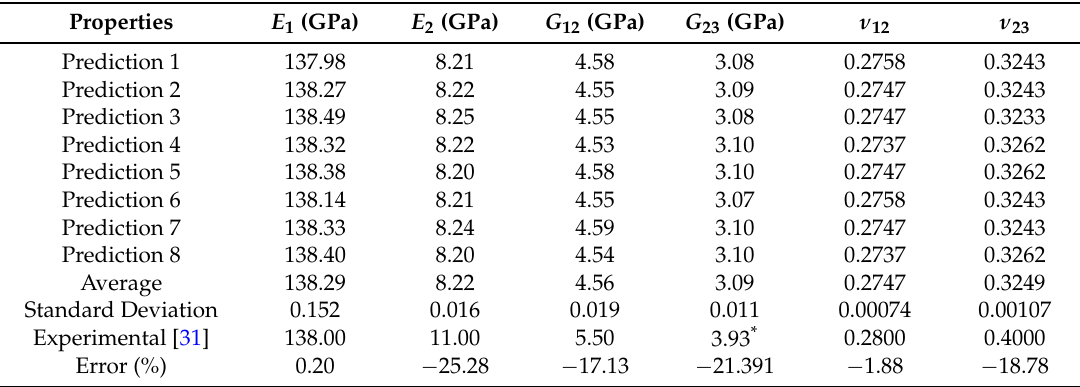
Table 2. Summary of predicted effective elastic properties and comparison with experimental